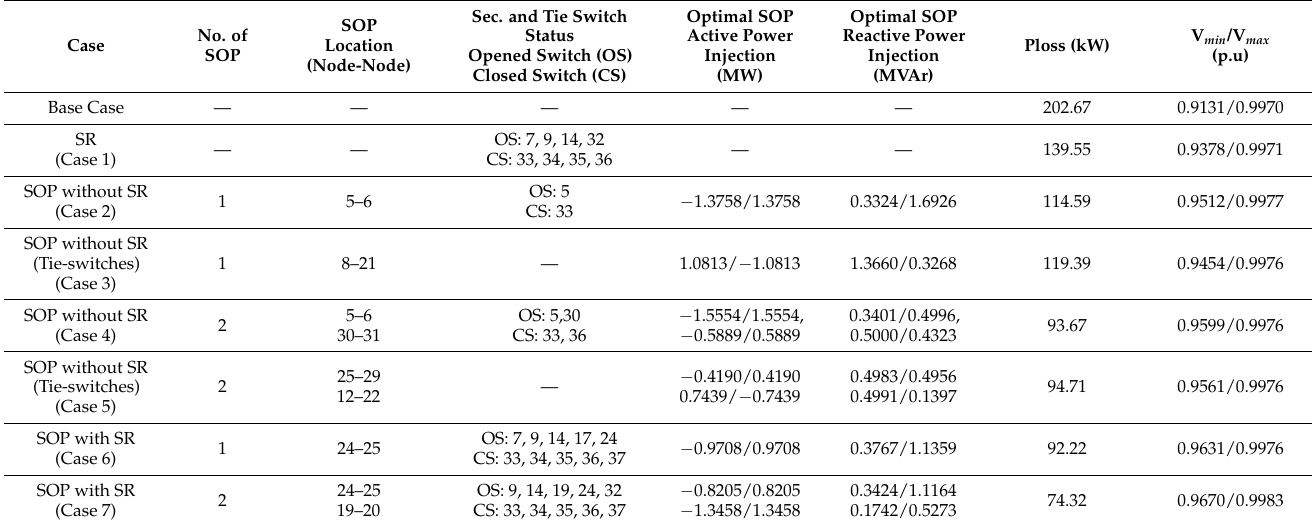
Table 1. Numerical results for IEEE 33-Node with and without SOP installation.